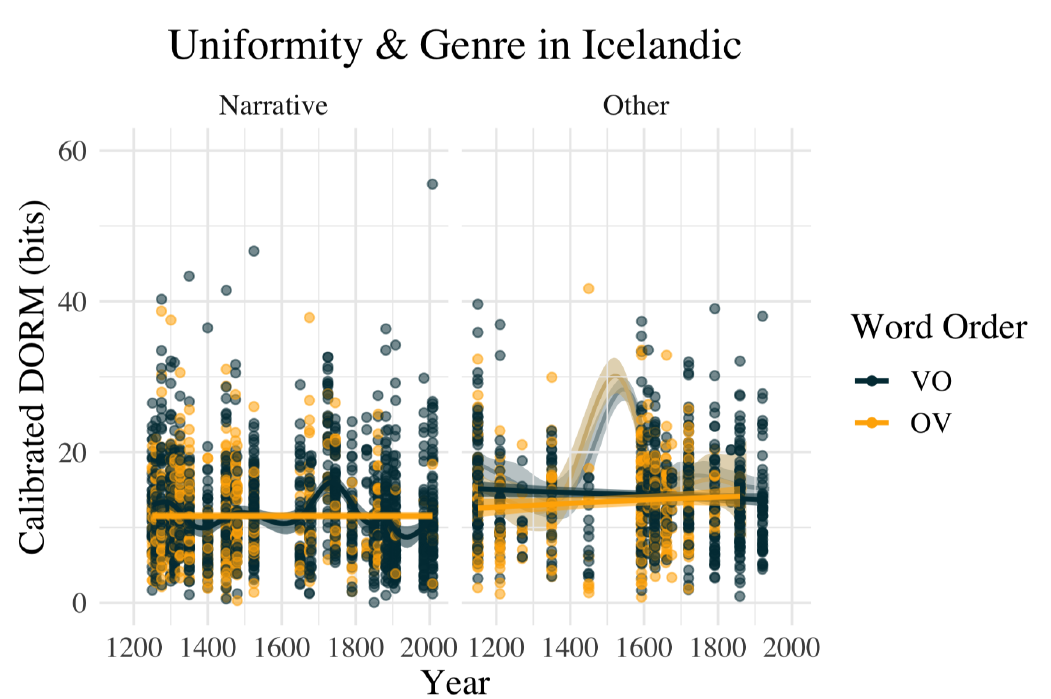
Figure 4. Calibrated DORMs for Icelandic sentences by Year, Word Order, and Genre (narrative vs. other). Note the small but stable effect of narrative texts in favoring more uniform sentences, and the important absence of a Year effect on information uniformity. An outlier, Oddur Gottskálksson’s New Testament translation from 1540, is excluded from the solid lines in “Other”, but included in the shaded lines behind them (see Section